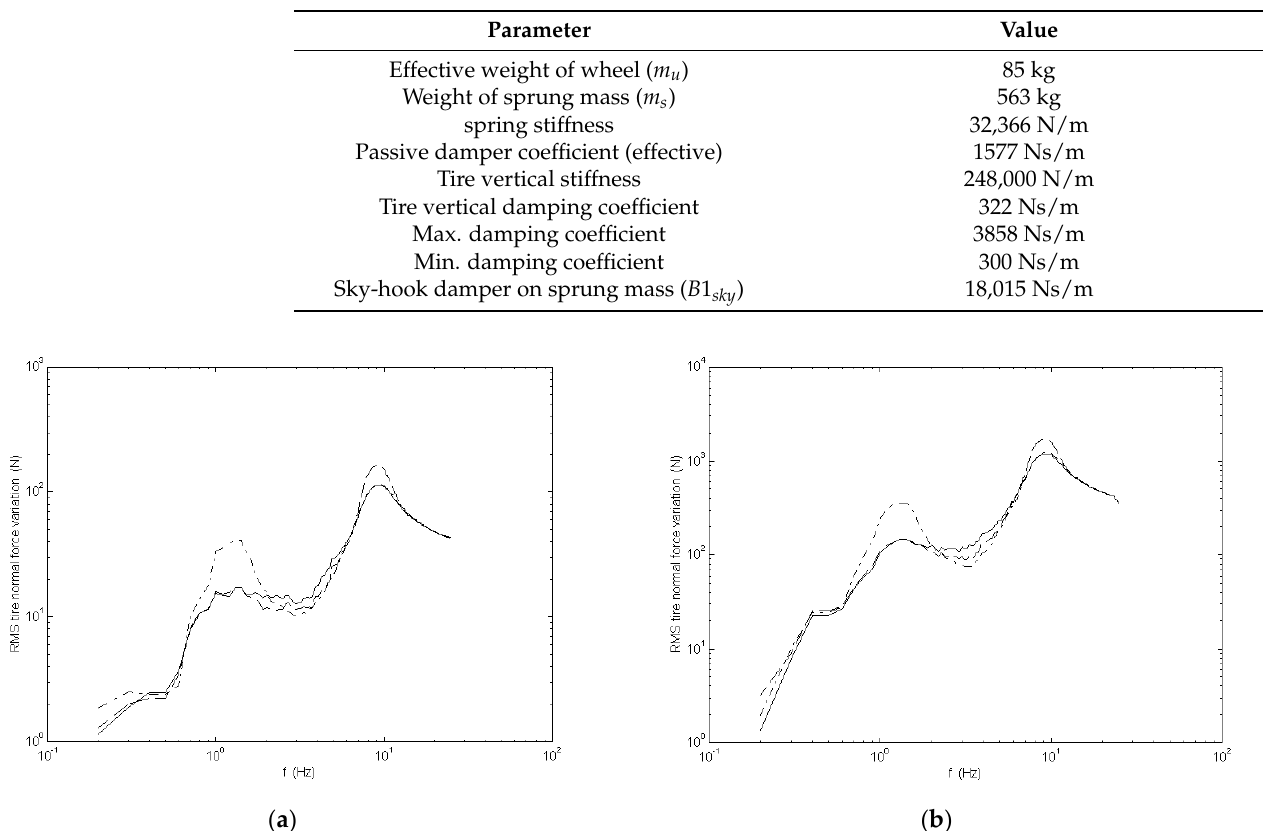
Table 1. Model parameters for the quarter car.